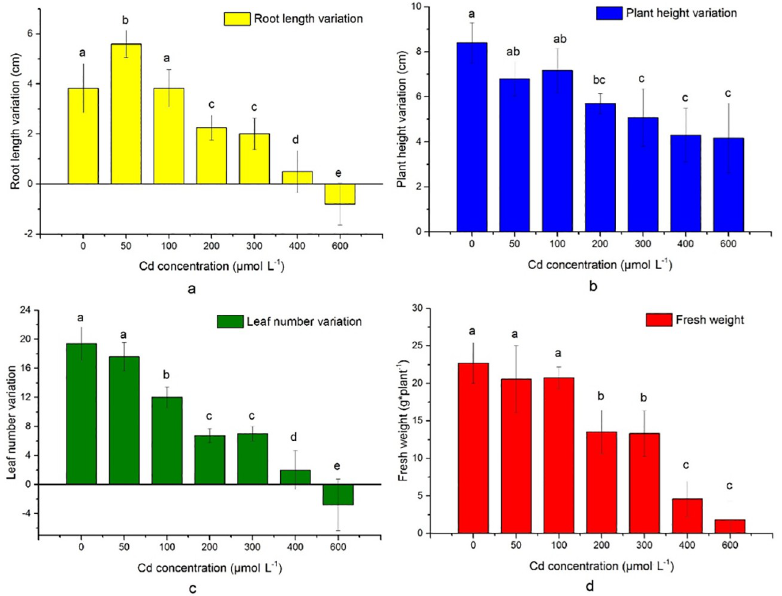
Fig 1. Effects on different Cd treatments on physical parameters of S . portulacastrum (Different letters in different treatments suggest significant difference (P < 0.05) between treatments according to ANOVA and Turkey